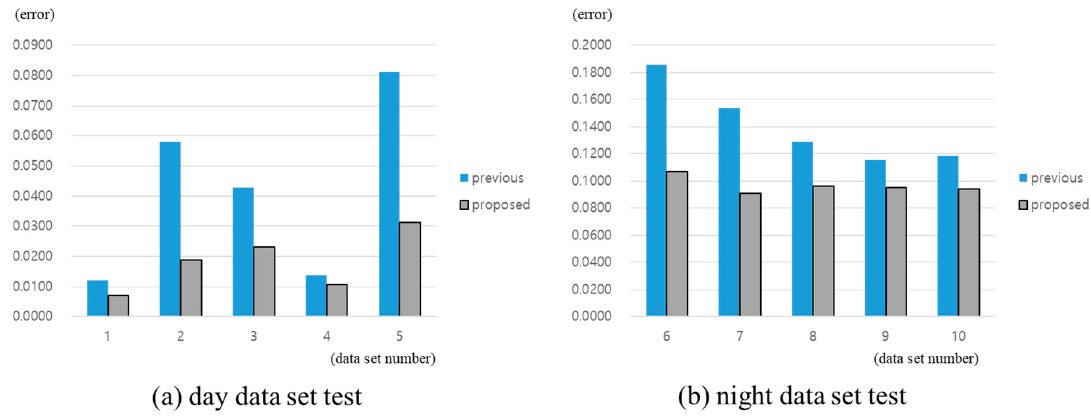
Figure 13. The results of the real-world data test: ( a ) Day data set test; ( b ) night data set test.